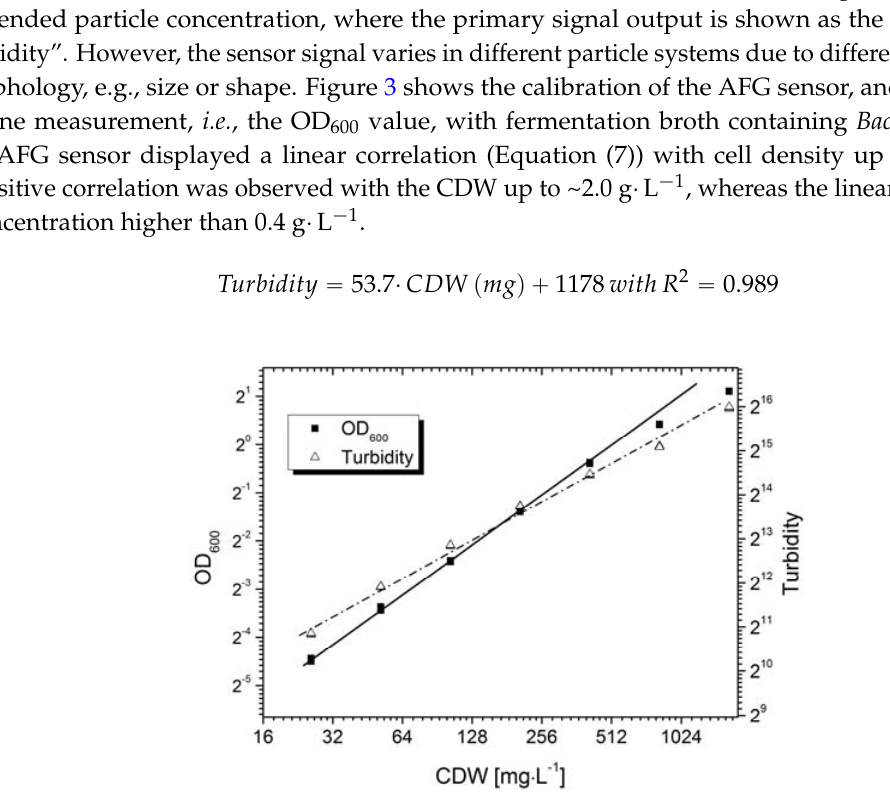
Figure 4. Online monitoring of biomass during the batch fermentation of B. coagulans for the production of LA, using optical density (OD 600 ) and cell dry weight (CDW) as reference methods. The values of OD 600 and CDW were determined three times.